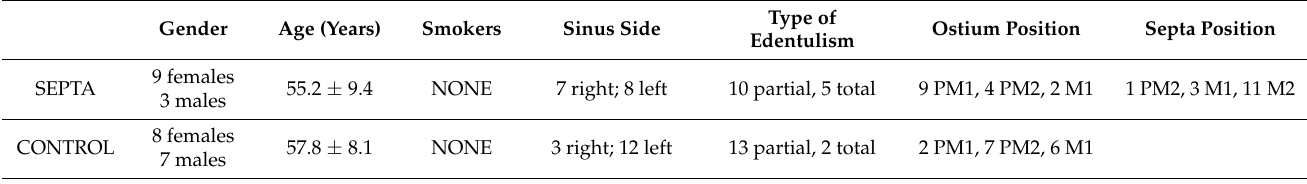
Table 1. Demographic and clinical data. Sinuses n =